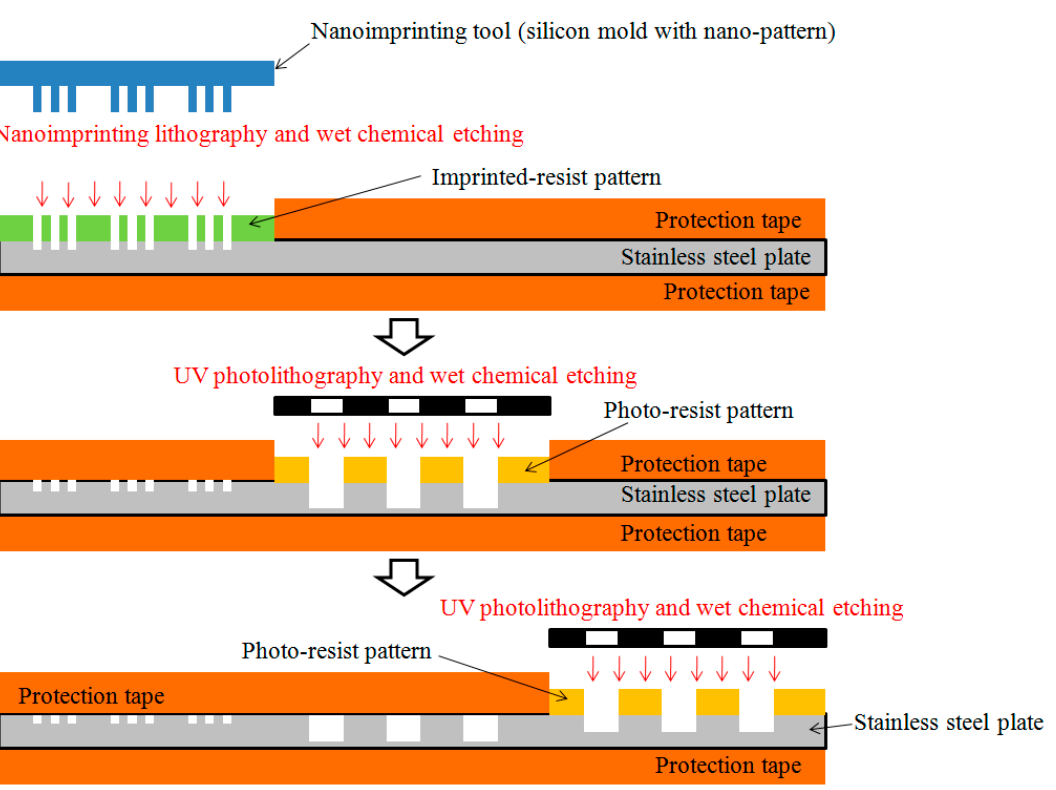
Figure 2. Procedure for fabricating the master mold with three different microstructure patterns.